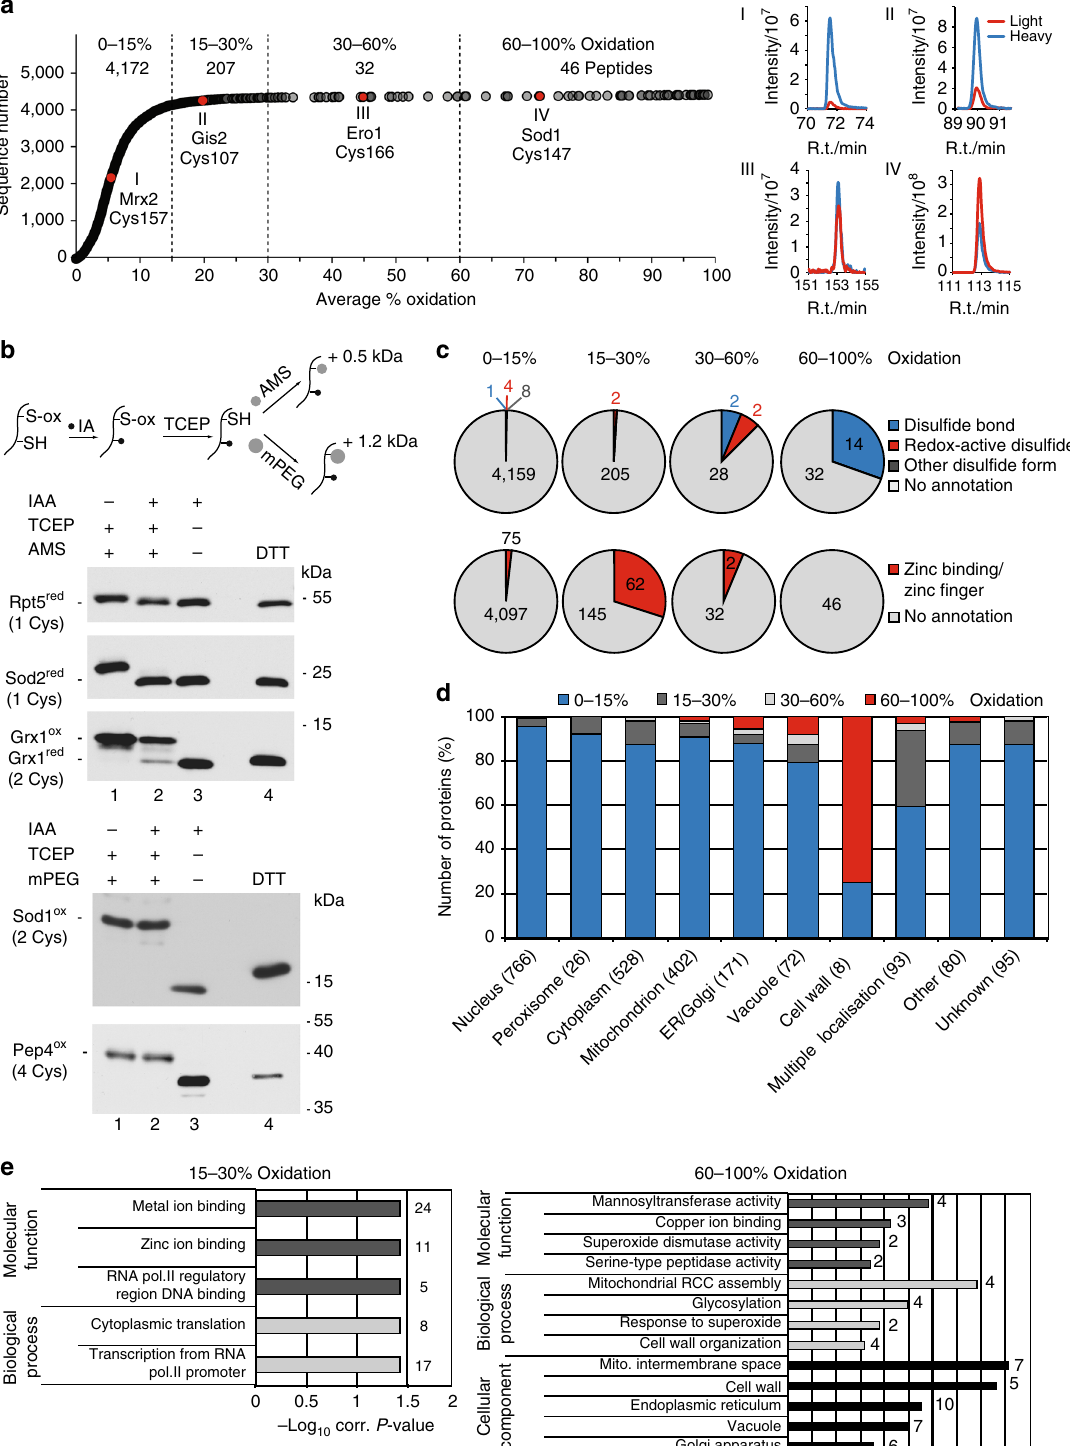
RNA pol.II regulatory region DNA